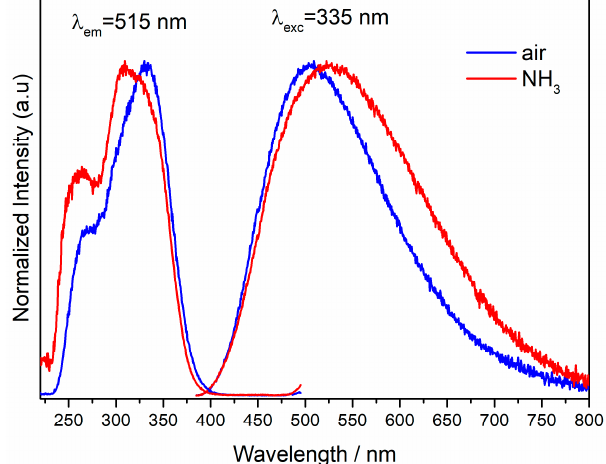
Figure 3. Room temperature excitation and emission spectra of Ca 2 NaMg 2 V 3 O 12 obtained at different